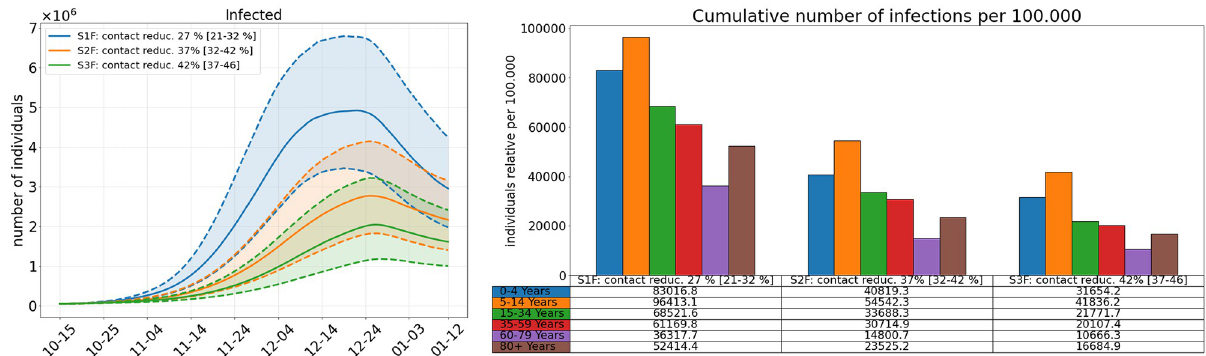
Fig 10. Comparison of three different model scenarios for future developments assuming Delta to be 60% more infectious than the Alpha variant. In all scenarios, masks and distancing are applied in school , work , and other (everything except home, school and work) locations but not in homes . For the Scenario 1F, an additional contact reduction between 5 and 15% is assumed in school , work , and other . For the Scenario 2F, contact reduction in schools and other is increased to 35–45% while home office is kept at an average of 10%. For the Scenario 3F, only home office is increased from 5–15 to 35–45% (compared to the Scenario 2F). Left : Median simulation results in solid lines for the number of infected individuals over the period October, 15, 2021 to January 12, 2021. Percentiles p25 and p75 shown in dashed lines. Right : Total number of infections per age group over the whole simulation period. The median values are also presented in the table below the